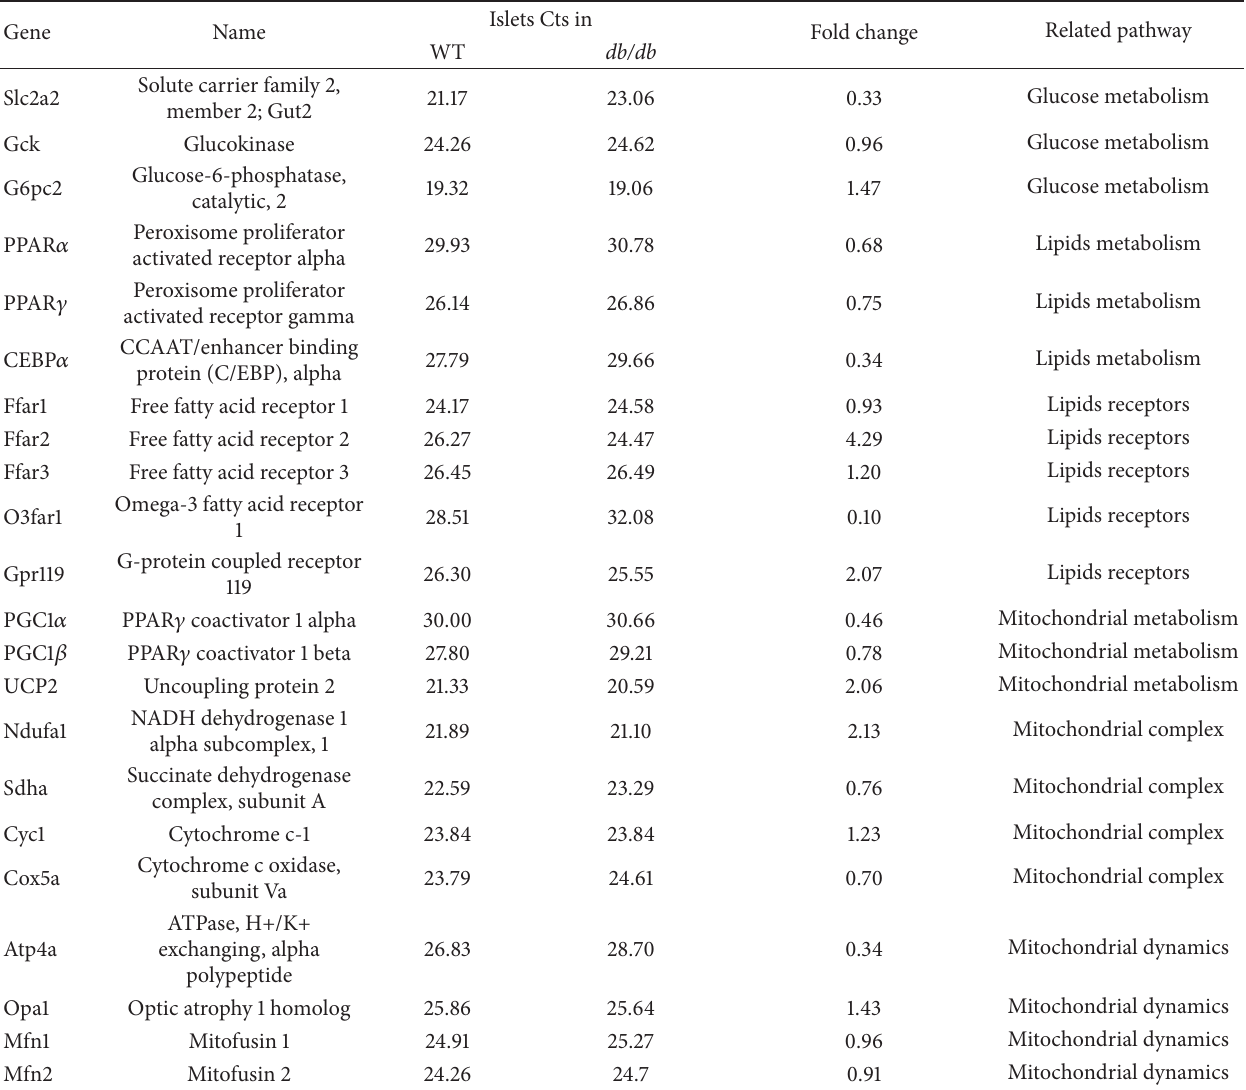
Table 1: mRNA expression of energy metabolism-related genes in islets from db/db mice. Total RNA was extracted from a pool of 335 and 312 islets from WT ( 𝑛 = 11 ) and db/db ( 𝑛 = 12 ) male mice, respectively. Relative mRNA levels of genes related to glucose and lipid metabolism and to mitochondrial function were evaluated by RT-qPCR using custom RT-Profiler. The mRNA levels are expressed as fold-change in 2 −Δ Ct of the specific gene in islets from db/db relative to WT mice (see Section